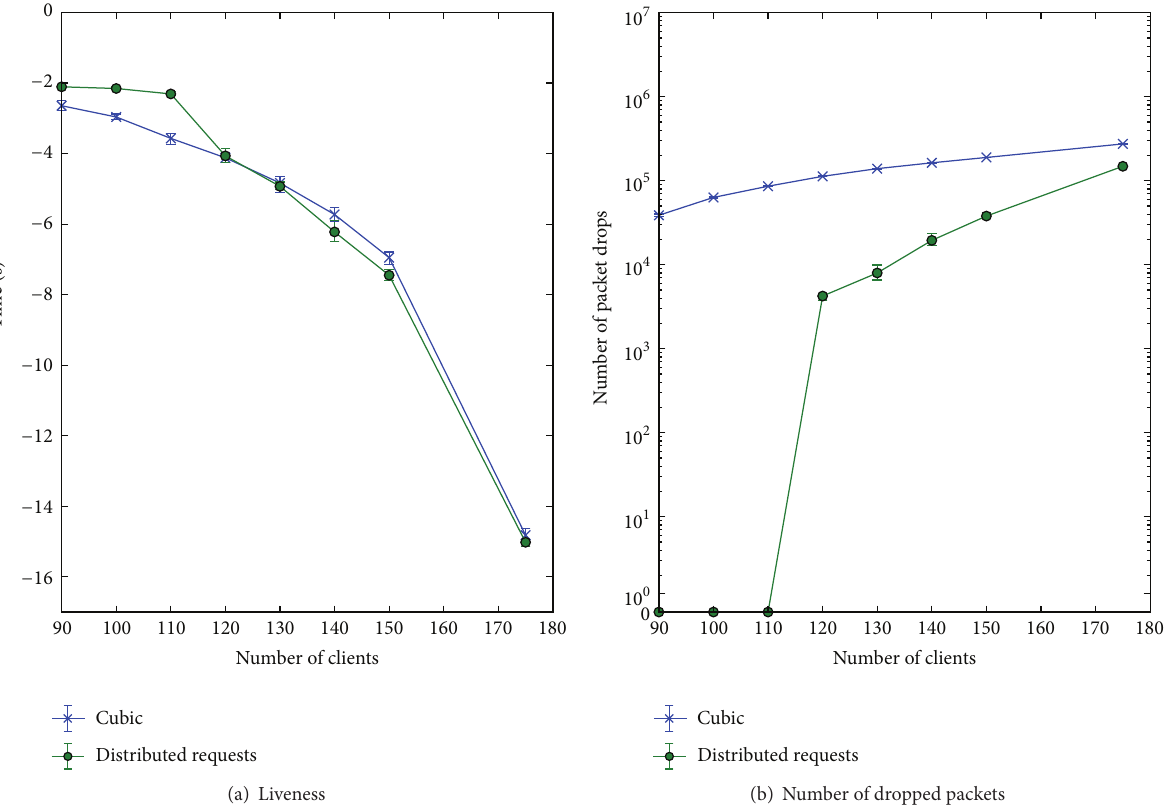
Figure 7: Performance of regular versus distributed